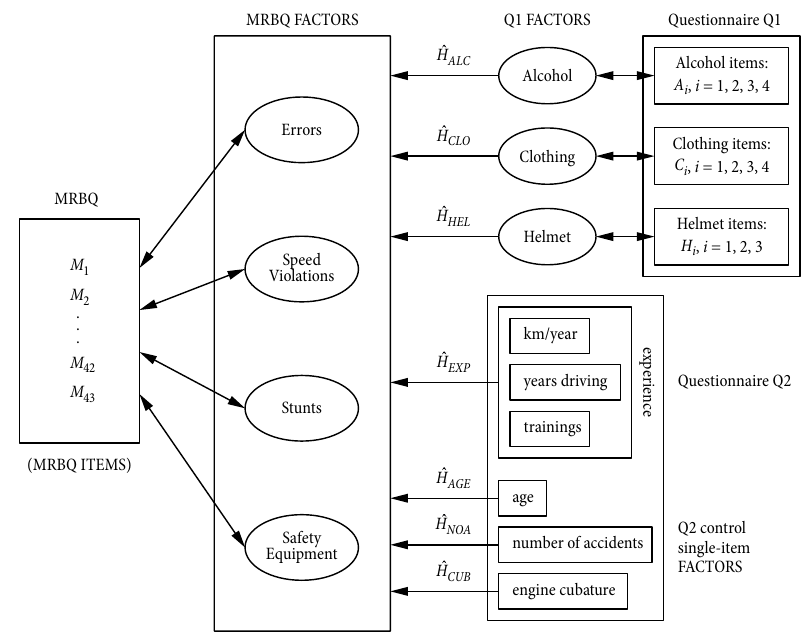
Fig. 1. The conceptual framework (Q1 factors – motorcyclists’ subjective opinion about proper behaving; MRBQ factors – motorcyclists’ actual